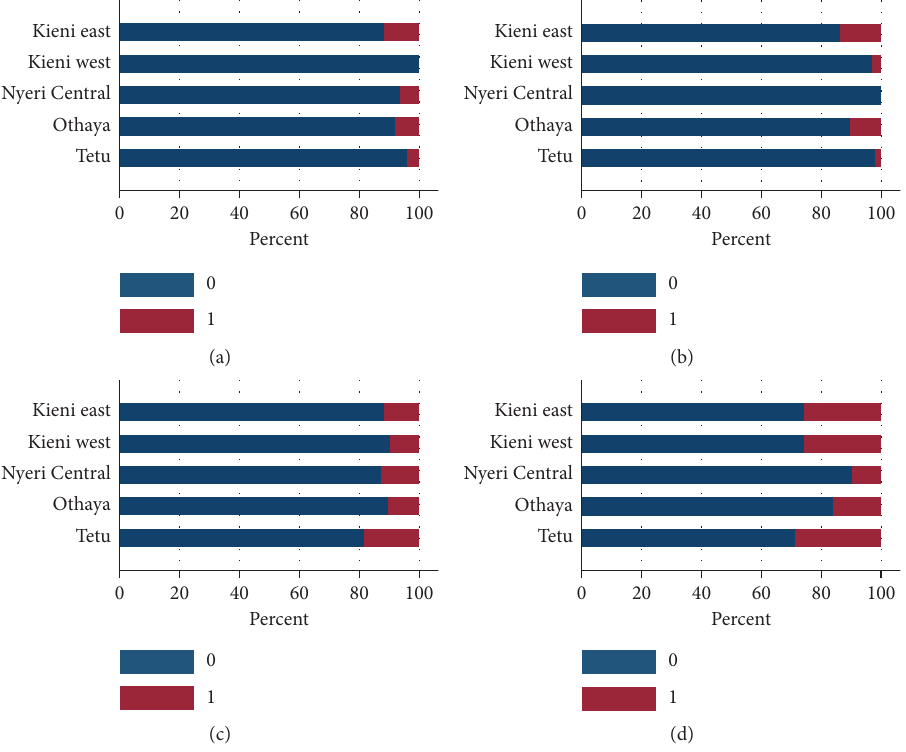
Figure 11: Clinical signs as observed by farmers in different subcounties. 0 � not observed; 1 � observed. Percentages are per clinical sign/ observation. Higher percentage of farmers identified “floating fish” and “swollen abdomen” as signs of disease. (a) Skin lesions. (b) Abnormal skin color. (c) Swollen abdomen. (d) Floating fish.